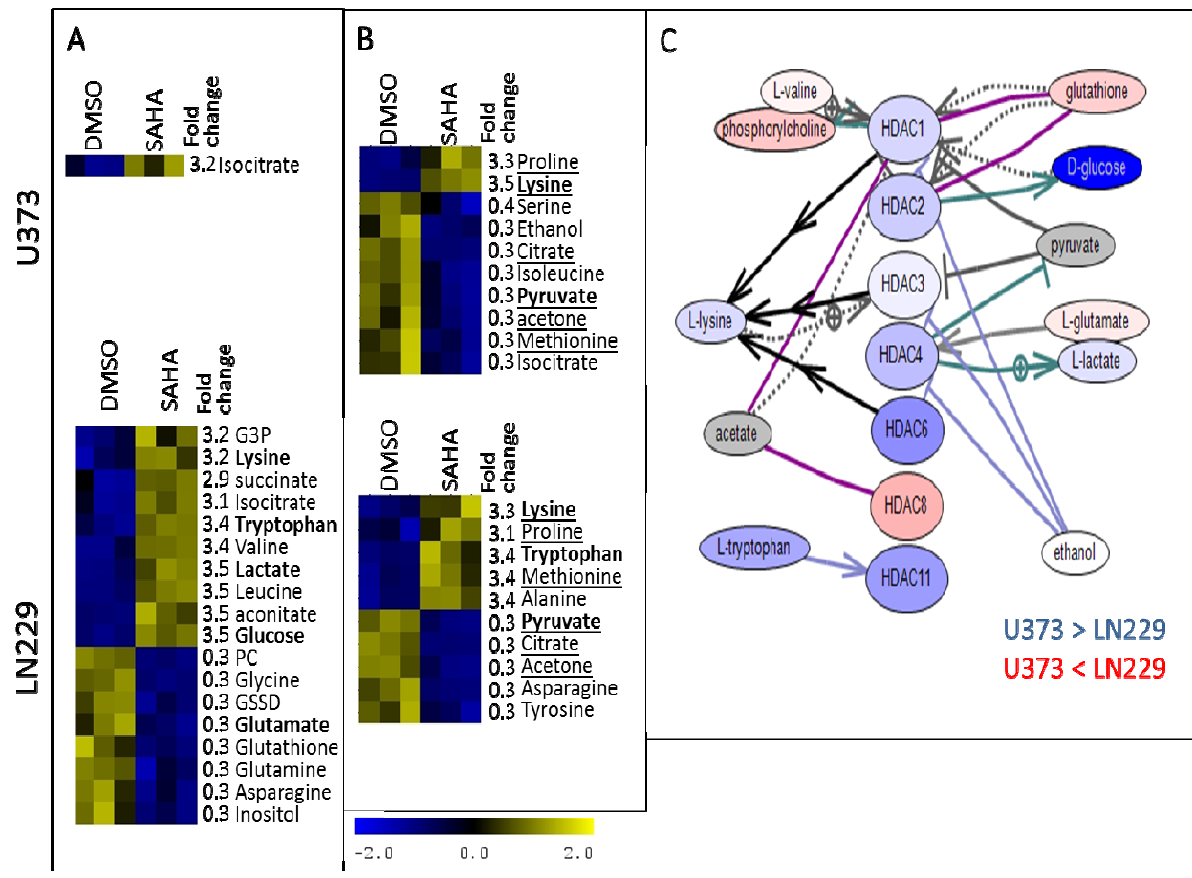
Figure 8. Major metabolic differences induced by SAHA treatment in intracellular ( A ) and extracellular ( B ) samples. Metabolites that are most significantly changed by treatment in U373 and LN229 cells are underlined. Metabolites that are shown in Figure 8C are shown in bold. ( C ) Pathway Studio determined literature-based relationships between different HDACs and select metabolites. Gene expression values were obtained from publicly available microarray measurements [49] Shown are metabolite concentrations in control samples (DMSO treatment). For both genes and metabolites, blue corresponds to a higher concentration in U373 cells relative to LN229 cells and red represents higher concentration in LN229 cells, with darker colors indicating a larger relative difference. Ethanol (white) is equally concentrated in two cell lines. The concentrations of acetate and pyruvate are not available